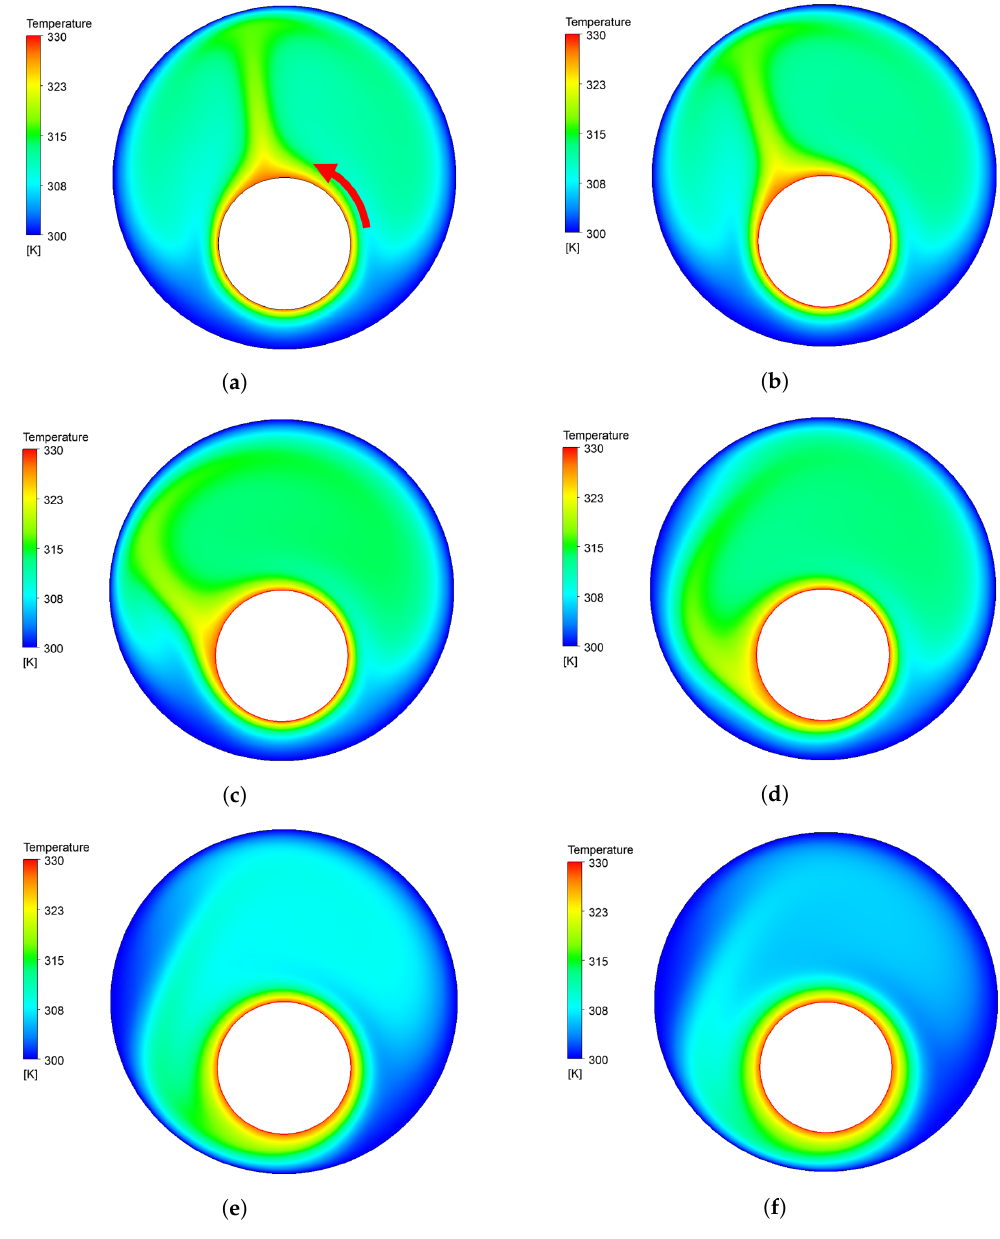
Figure 5. Numerical solutions for the inner-rotating cylinders: ( a ) 2 rad/s; ( b ) 5 rad/s; ( c ) 10 rad/s; ( d ) 15 rad/s; ( e ) 20 rad/s; and ( f ) 25